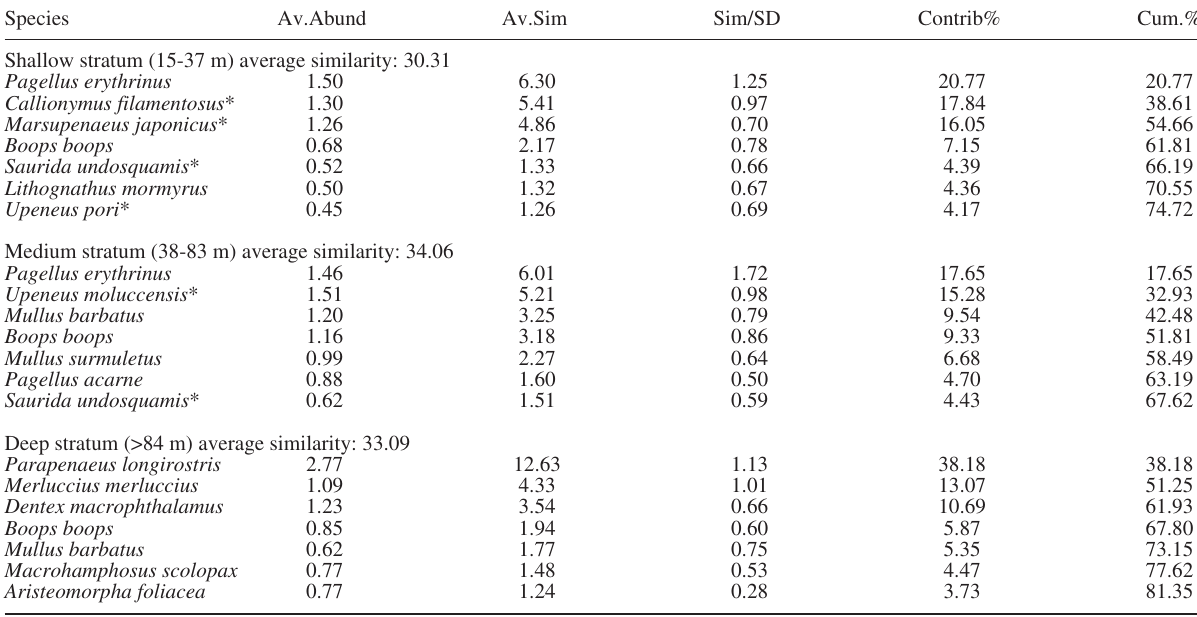
Table 4. – Results of a nonparametric SIMPER procedure based on a square root transformed Bray-Curtis similarity index of the number of specimens per hour of trawling. The contribution of the dominant species to the similarity % (Contrib%) of the 3 depth strata is described for the 7 dominant species of each stratum. Other parameters include the average contribution to abundance, similarity, similarity/standard deviation and cumulative similarity. Species